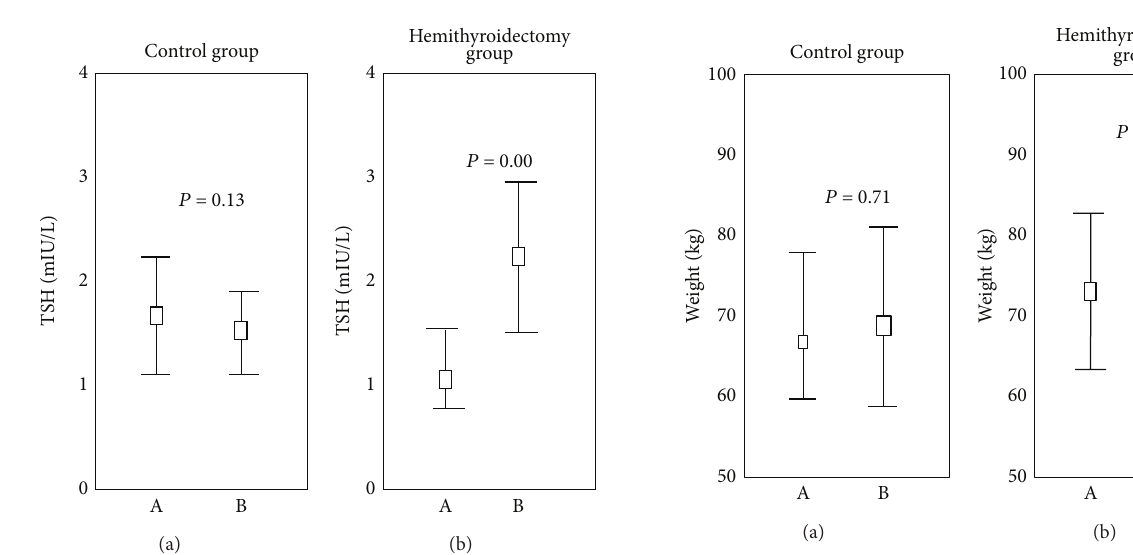
Figure 1: TSH changes between baseline and follow-up. TSH changes of the hemithyroidectomy group ( 𝑛 = 28 ) and of the control group ( 𝑛 = 47 ) after a two-year follow-up period. The median, upper, and lower quartiles are presented. Outliers are excluded. The Wilcoxon signed-rank test was used. Statistical significance was demonstrated whenever 𝑃 < 0.05 .